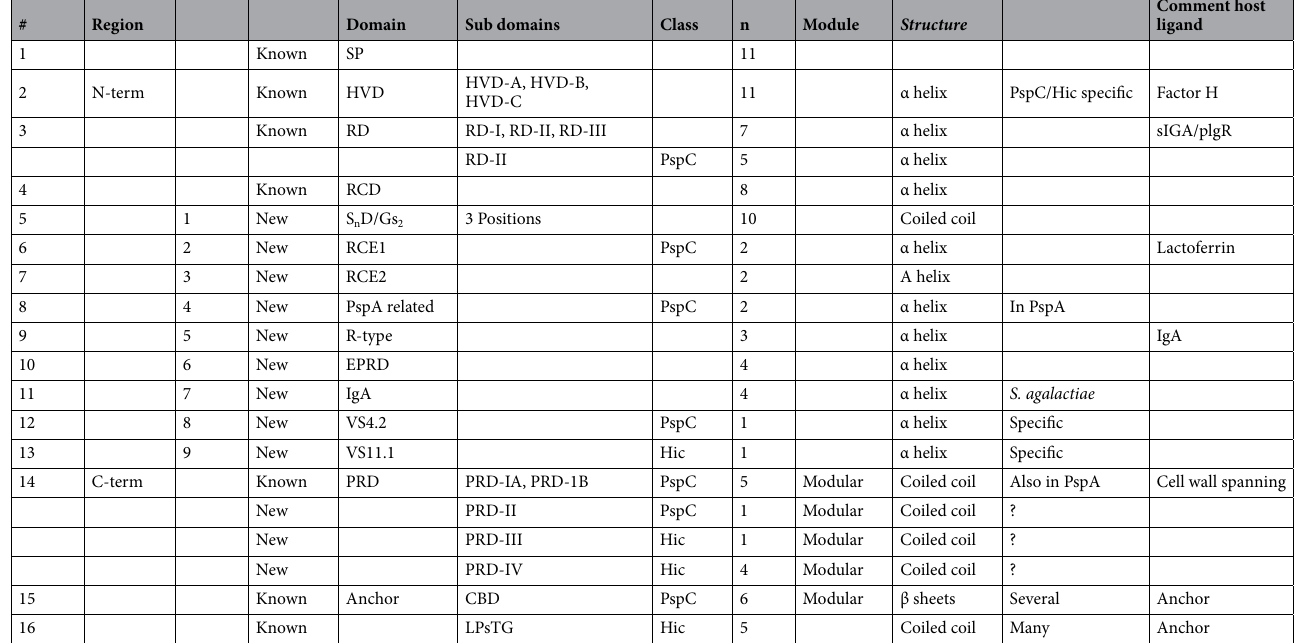
Table 2. Domain used by S. pneumoniae PspC and Hic proteins. The binding sites for Factor H has been mapped within the Hypervariable Domain of PspC3.1 and that of sIgA and the extracellular domain of pIgR to the RNYPT motif of Repeat Domains I and II. C3, C4BP, Plasminogen, Thrombospondin 1, vitronectin have been shown to bind intact S. pneumoniae and full length PspC and Hic proteins, but their binding sites have not been mapped to specific domains. Binding of Lactoferrin and IgA is proposed based on the homology between PspC and Hic variants and the S. pneumoniae immune escape protein PspA and the sIgA binding protein of S.